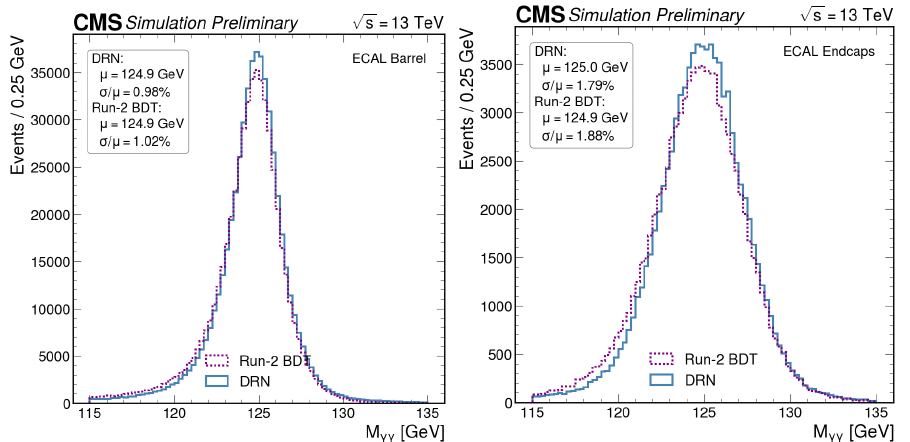
Figure 6. Di-photon invariant mass distributions of H → γγ events for both the Dynamic Reduction Network (DRN) and Boosted Decision Tree architectures in the ECAL barrel ( left ) and endcaps ( right ). The DRN shows an improved resolution by >5% in both detector